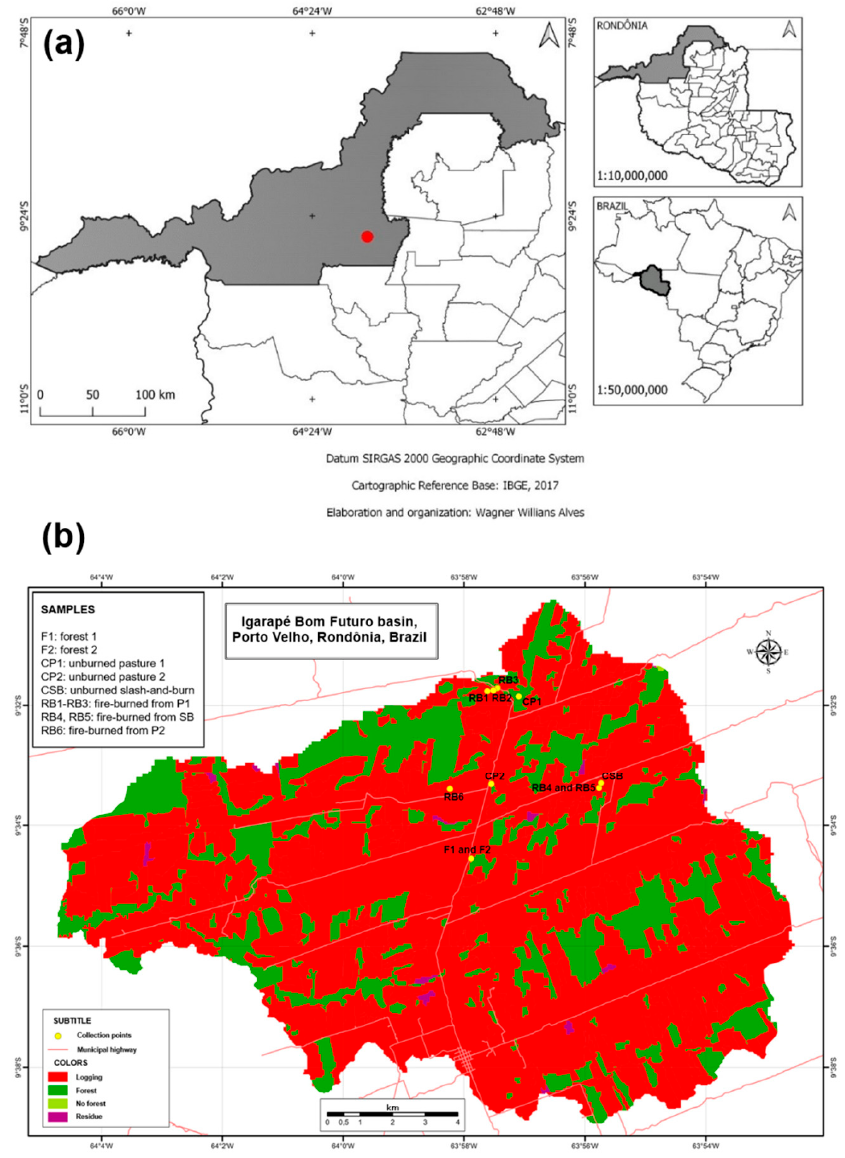
Figure 1. Study area at Rondônia, Brazil. F1—forest 1, F2—forest 2, P1—pasture 1, P2—pasture 2, SB—slash-and-burn. ( a ) Location of the studied area and ( b ) sampling points.